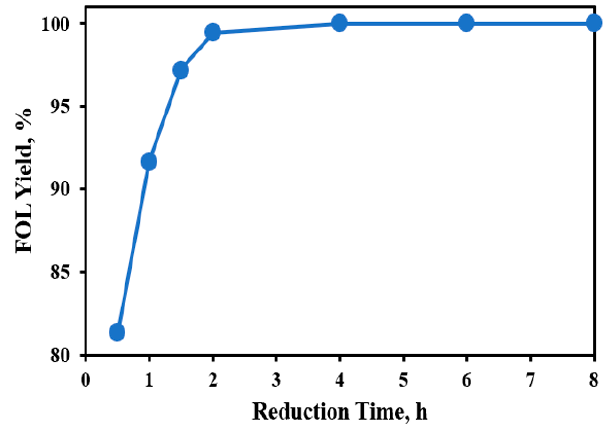
Figure 8. Time course of 100 mM FAL into FOL by KP ADH cells (FAL 100 mM, 30 °C, pH 7.5, NAD + /FAL 0.5:1 (mmol:mol), glucose/FAL 2.5:1 (mol:mol), cell wet weight 0.1